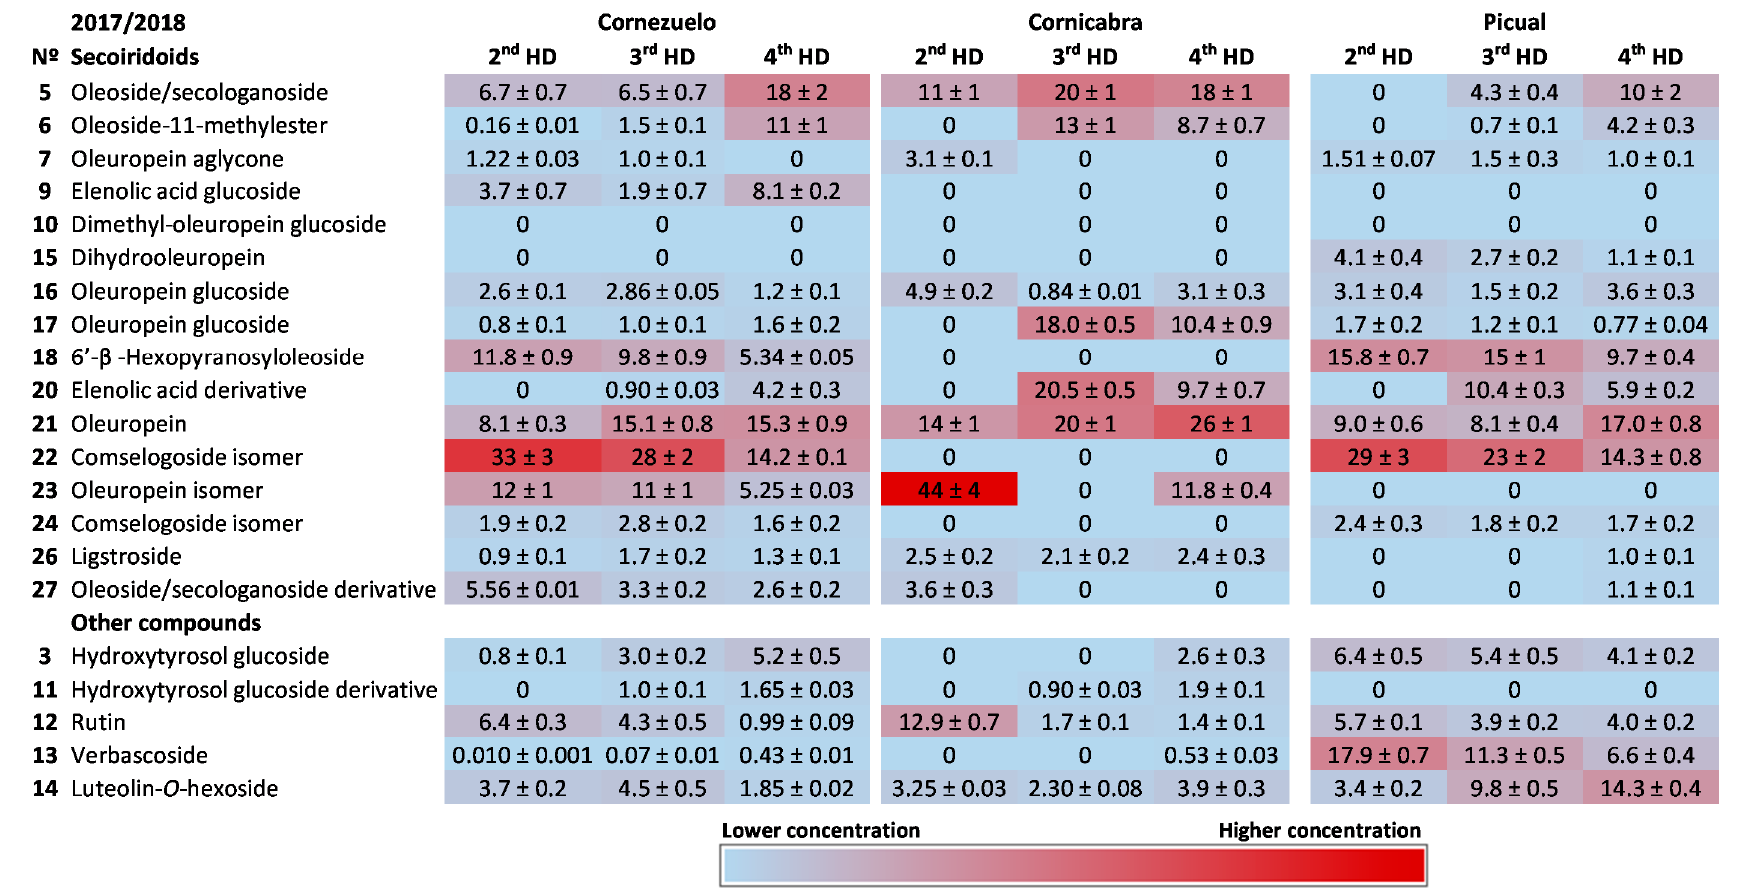
Figure 3. Heatmap showing the quantification of compounds in extracts of Cornezuelo, Cornicabra and Picual olives during the season 2017/2018 in different ripening stages using a colour scale. Data are given as percentage ± standard deviation ( n = 3).